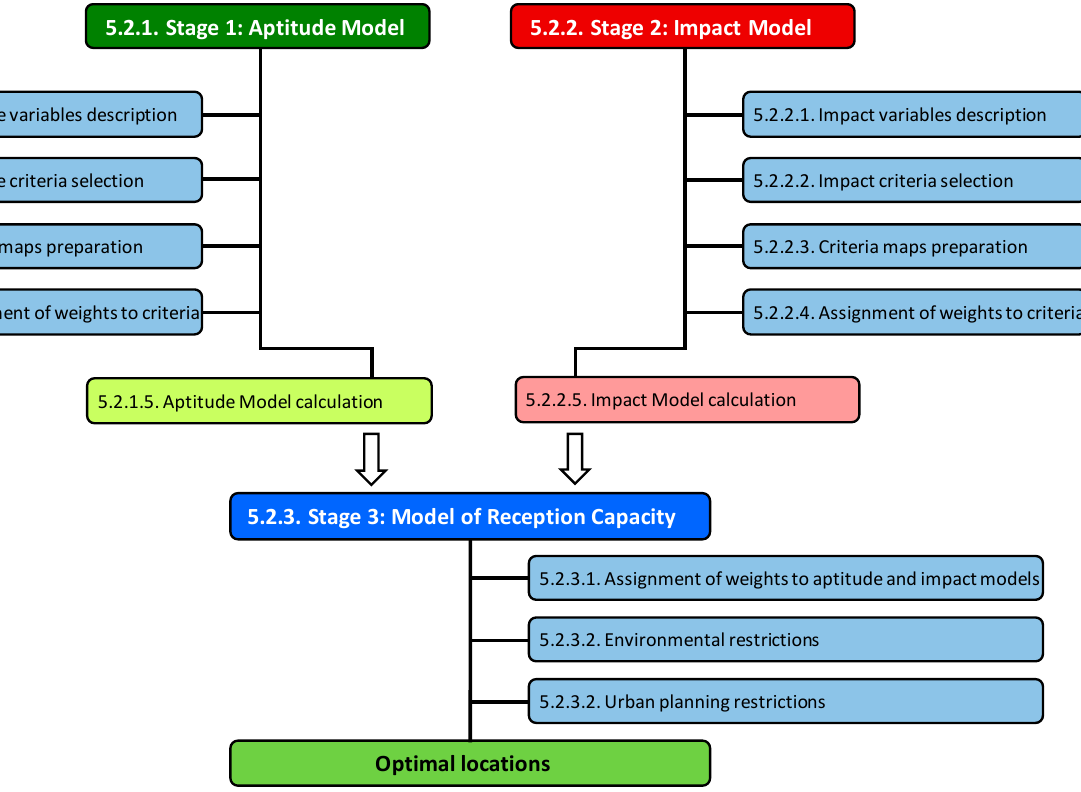
Figure 1. Methodology diagram for locating photovoltaic solar energy installations.